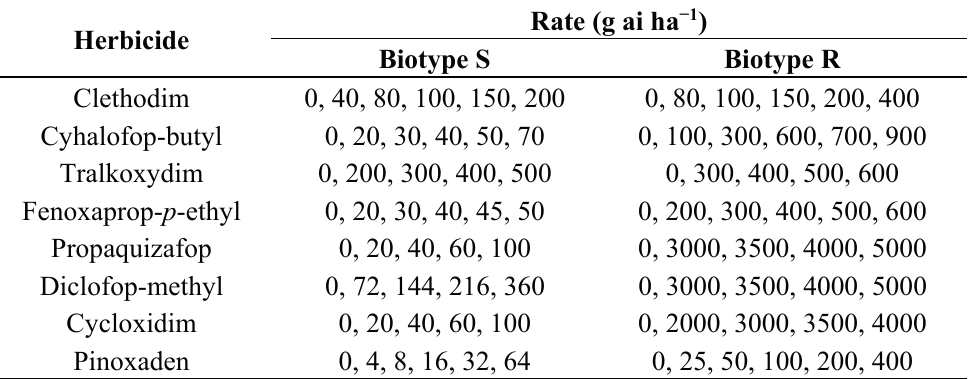
Table 5. Herbicide treatments applied for dose-response assays in P. minor